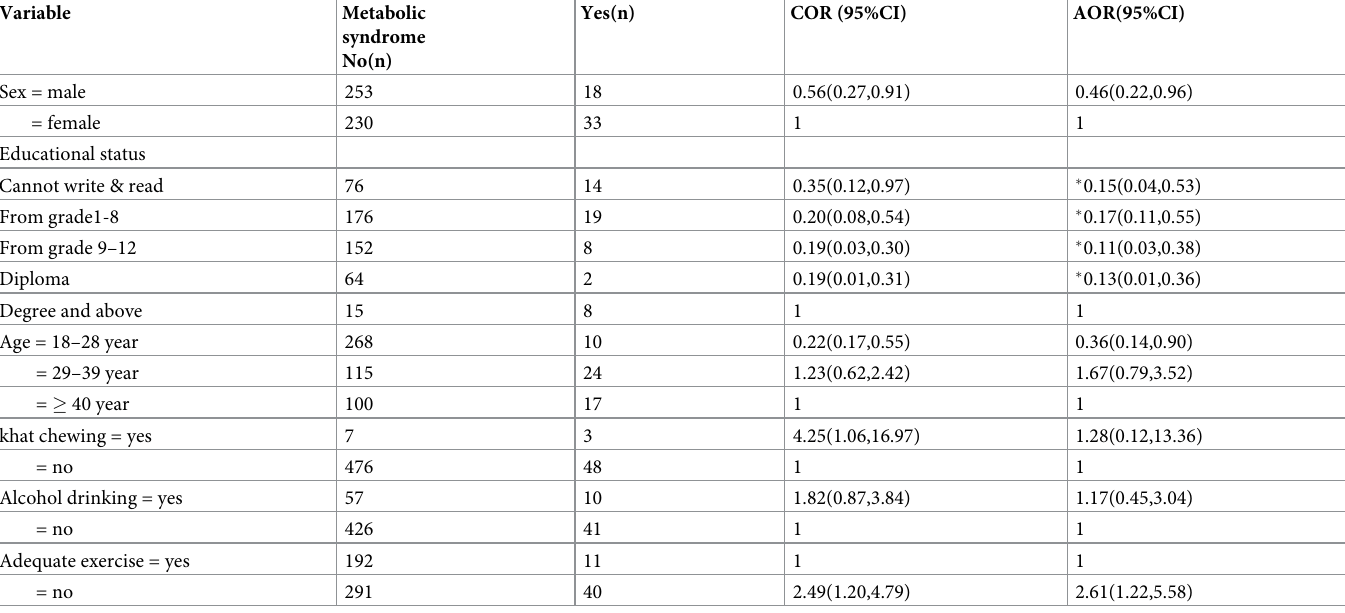
Table 5. Logistic regression of associated factors and metabolic syndrome among residents of Mizan-Aman town, south west Ethiopia, 2017 (n =